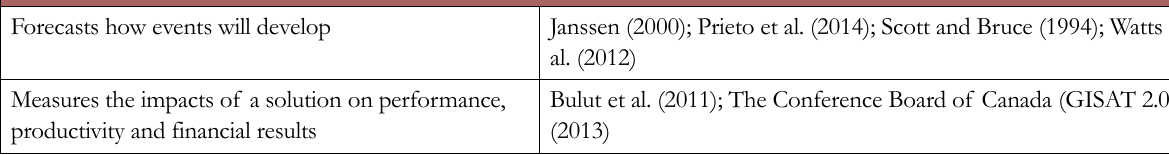
Table 11. Behaviours showing “foreseeing”